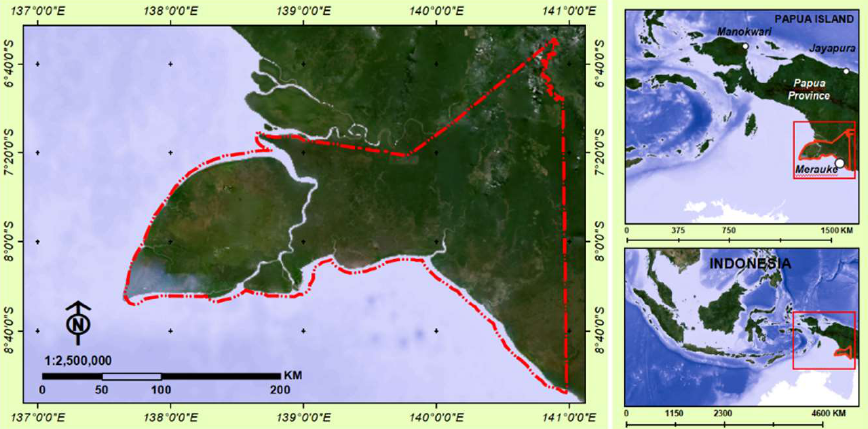
Figure 2. Location of study area: Merauke Regency. Consisting of 20 districts that cover an area of 46,791.63 km 2 with a population of 230,932 in 2020.